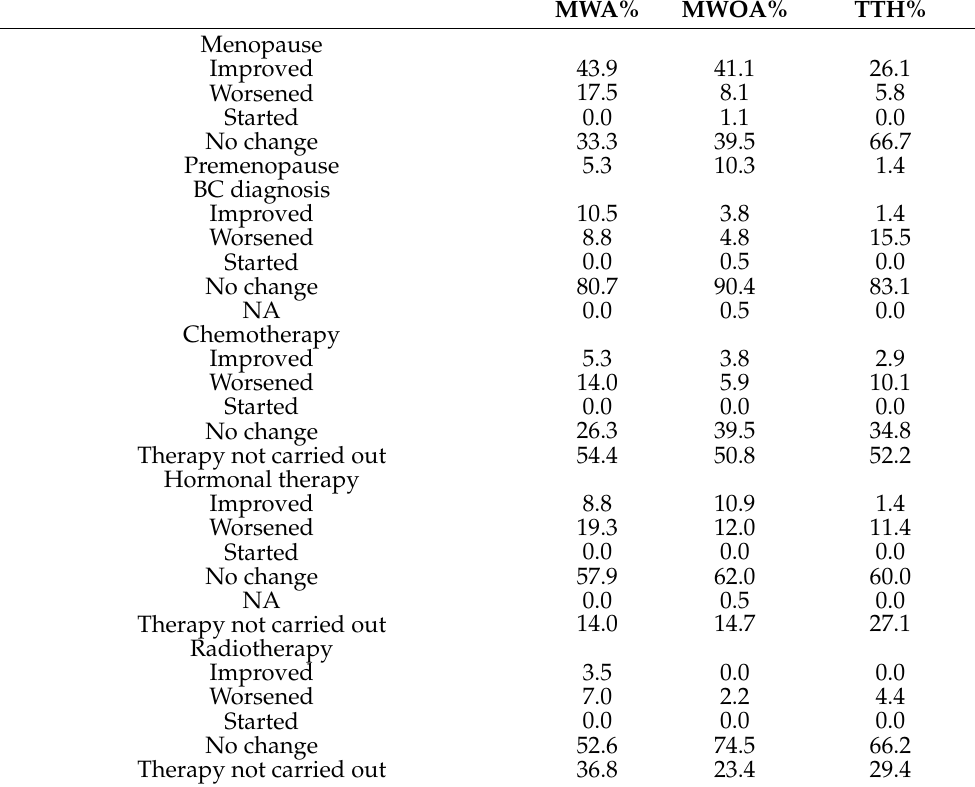
Table 4. Headache variation in relation to menopause, BC diagnosis, and